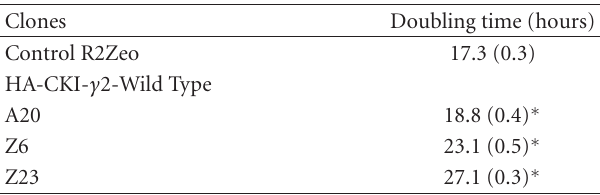
Table 1: Calculated doubling time from cell proliferation assays. Clones